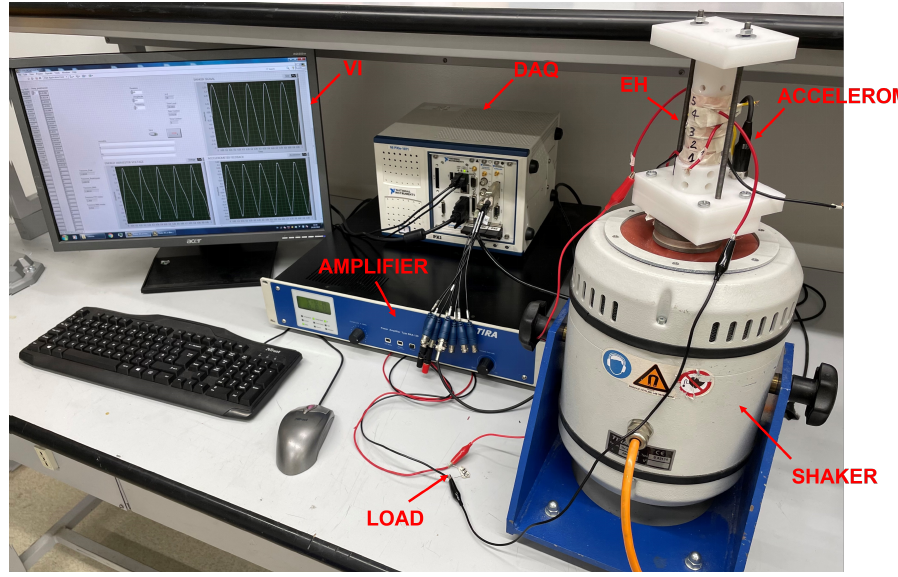
Figure 9. Experimental setup